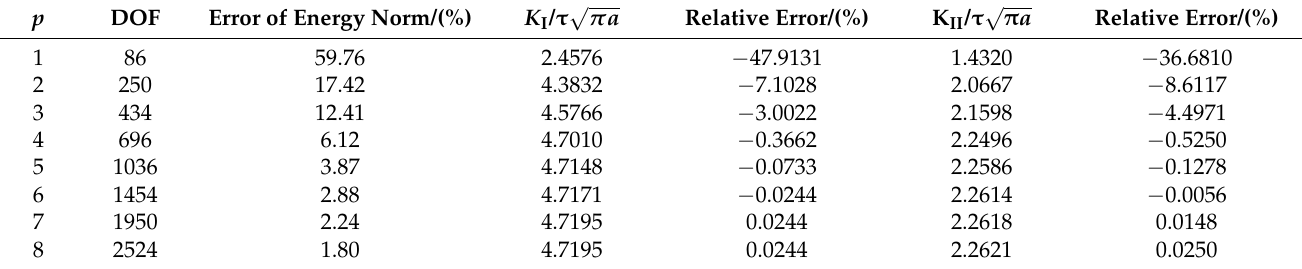
Table 4. Errors of energy norm of the P-FEM solutions and relative errors of normalized SIFs comparison with Abaqus solutions [6].